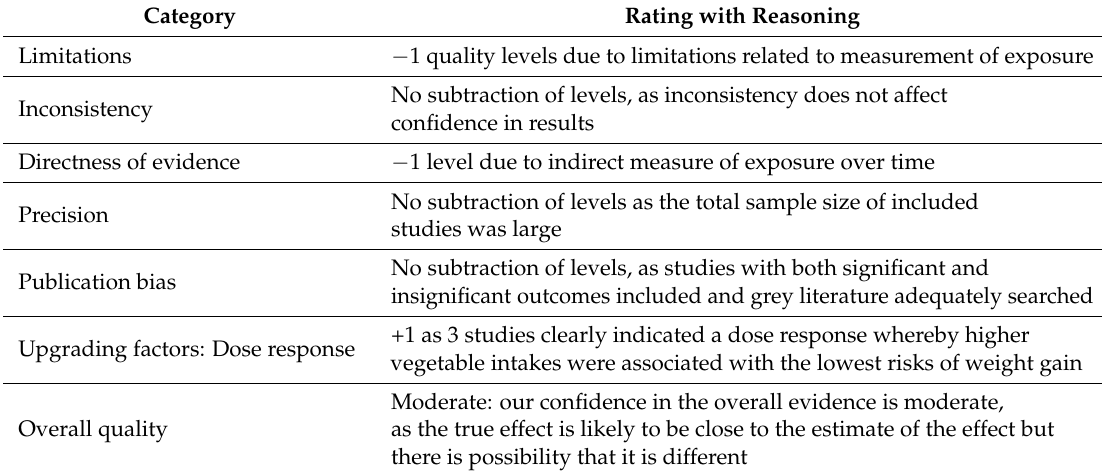
Table 6. Overall quality assessment of nine cohort studies (796,069 participants in total) examining the impact of vegetable consumption on anthropometric outcomes using the Grading of Recommendations Assessment, Development and Evaluation (GRADE) system. Rating with